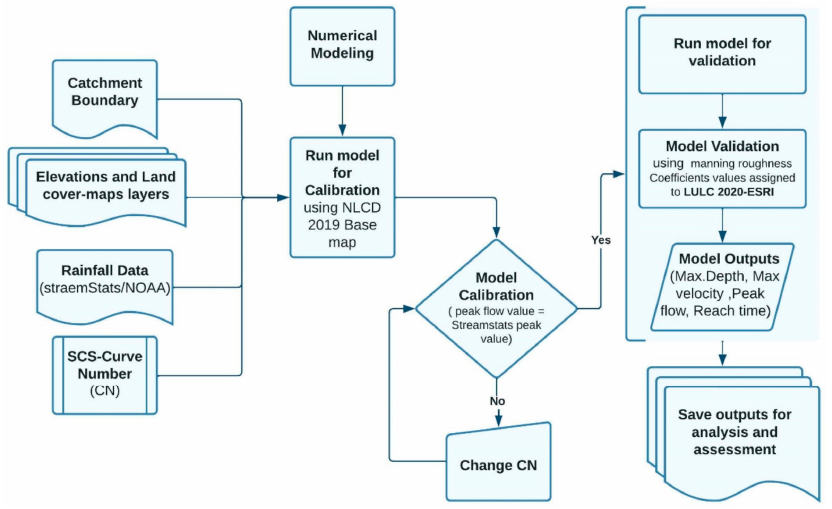
Figure 4. Research methodology for part 2: calibrating and validating the developed roughness maps using flood modeling.